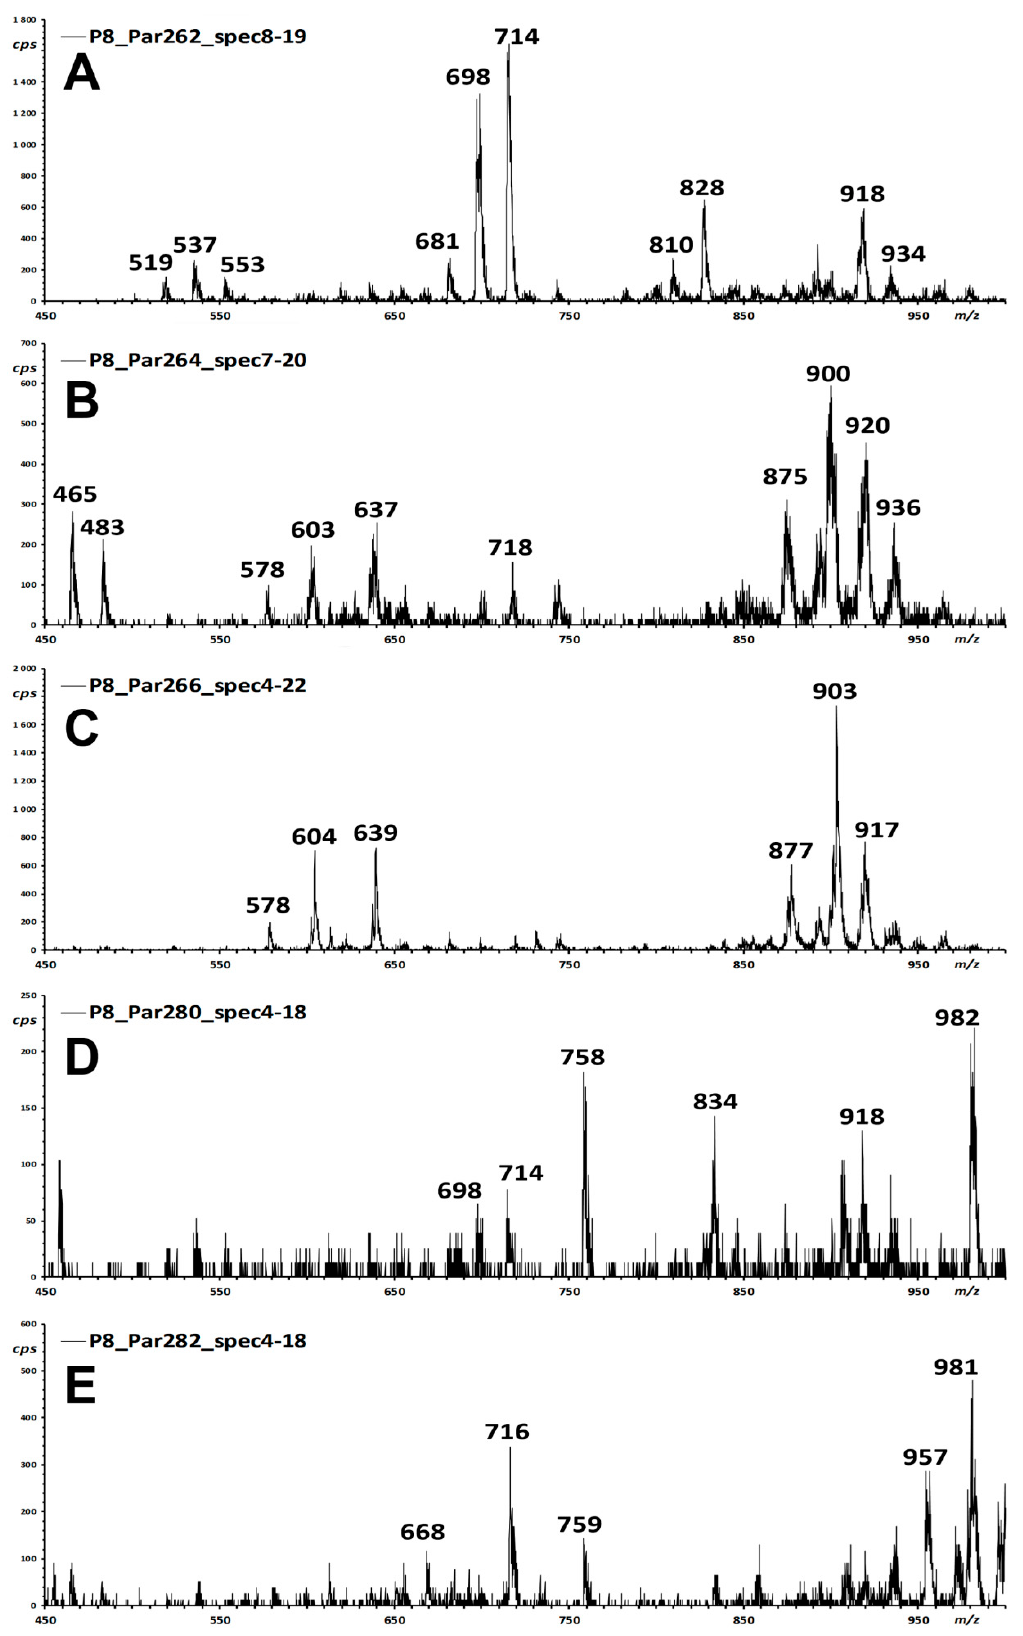
Figure 2. Integrated Precursor Ion mass spectra of the iso-energetic scan five long chain bases (( A – E ), see Table 1 for their structures) in the extract of a pistachio cultivar. Integration is performed, for all experiments, within the 3.5 to 21 min interval of the chromatographic traces of Figure 1. Labelled are the m / z values of some main signals.